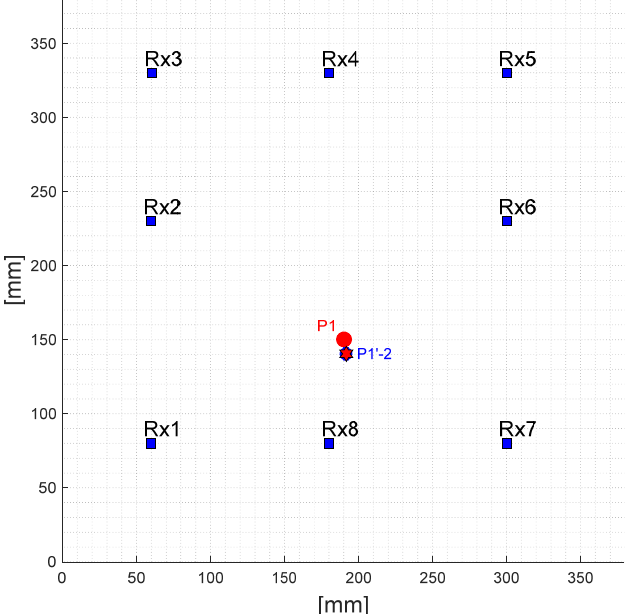
Figure 9. Position of impact P1 (red circle) inside the ROI with coordinates x i = 190 mm, y i = 150 mm. The detected impact position P1 ′ -2 (red star) with coordinates x p = 192 mm, y p = 141 mm was obtained by processing the ultrasonic signals acquired by all sensors (Rx1–Rx8). Reproduced from [24].